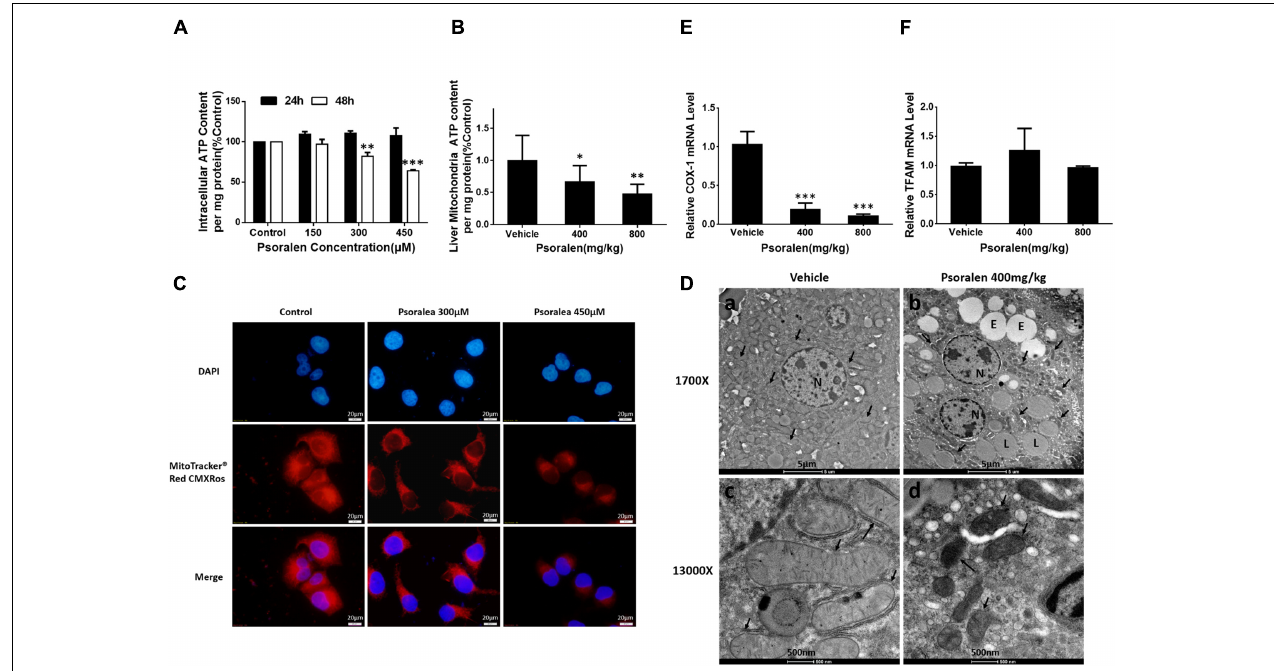
FIGURE 9 | Psoralen induced mitochondrial damage in vitro and in vivo . L02 cells were treated with DMSO, or 150 µ M, 300 µ M, or 450 µ M psoralen for 24 h or 48 h. (A) Intracellular ATP content of L02 cells. (C) Intracellular mitochondria of L02 cells were labelled with MitoTracker R (cid:13) Red CMXRos. The experiments were performed three times independently and the quantitative data are shown as the means ± SDs. ∗∗ p < 0.01, ∗∗∗ p < 0.001 versus control group. C57BL/6 mice were treated with 0.5% CMC-Na solution (vehicle group), or 400 mg/kg, or 800 mg/kg psoralen for 24 h. (B) ATP content of liver mitochondria in mice. (D) Transmission electron microscopy examination of liver sections ( n = 6). (a,c) vehicle group, (b,d) psoralen group. Upper panel: original magnification, 1,700 × ; lower panel: original magnification, 13,000 × . Massive mitochondria with normal morphology were observed in the vehicle group and abnormal morphology observed in the psoralen group (black arrow). Hepatocellular oedema (E), lipid droplets (L), and cell nuclei (N) are shown. (E,F) Real-time qPCR used to analyse the hepatic mRNA expression levels of COX-1 (E) and TFAM (F) in mice. Data of (B,E,F) are means ± SDs ( n = 8). ∗ p < 0.05, ∗∗ p < 0.01, ∗∗∗ p < 0.001 versus vehicle